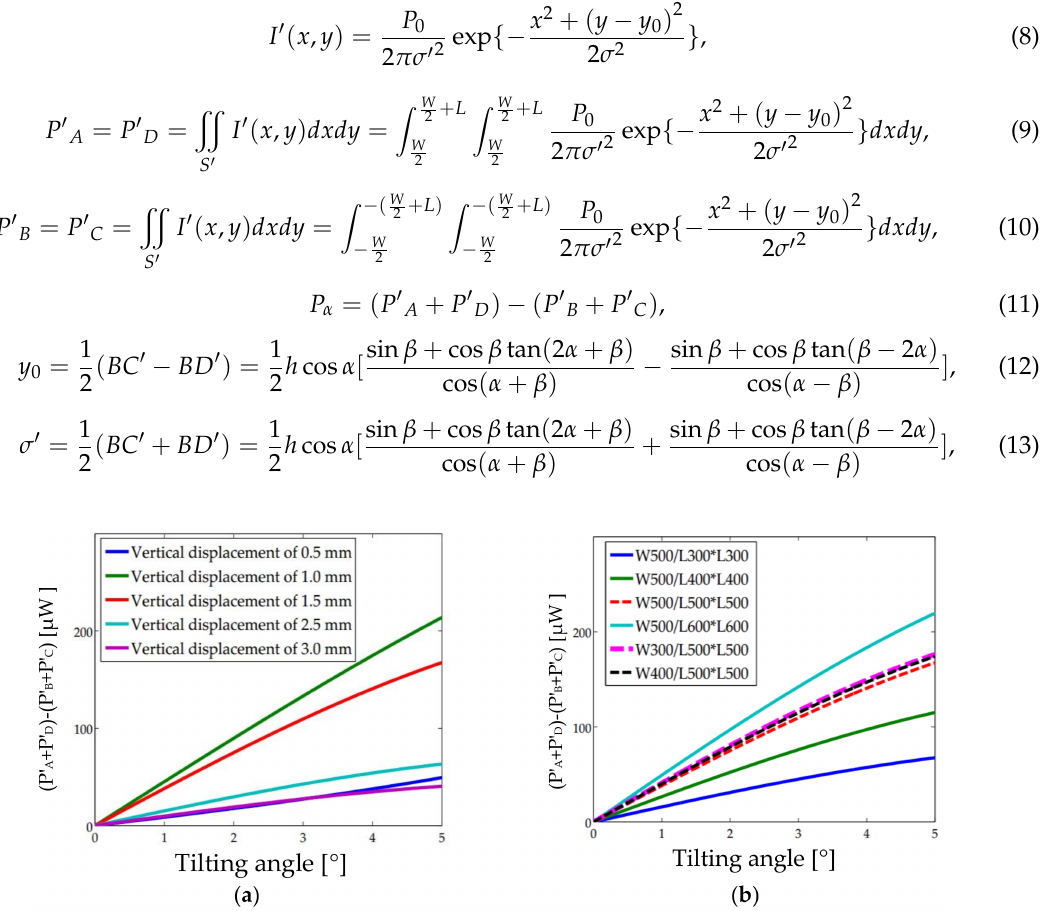
Figure 5. Output versus tilting angle. ( a ) Different vertical displacements with 2 β of 20 ◦ , W of 500 µ m, and L of 500 µ m; ( b ) Different W and L with β = 20 ◦ and h = 1.5